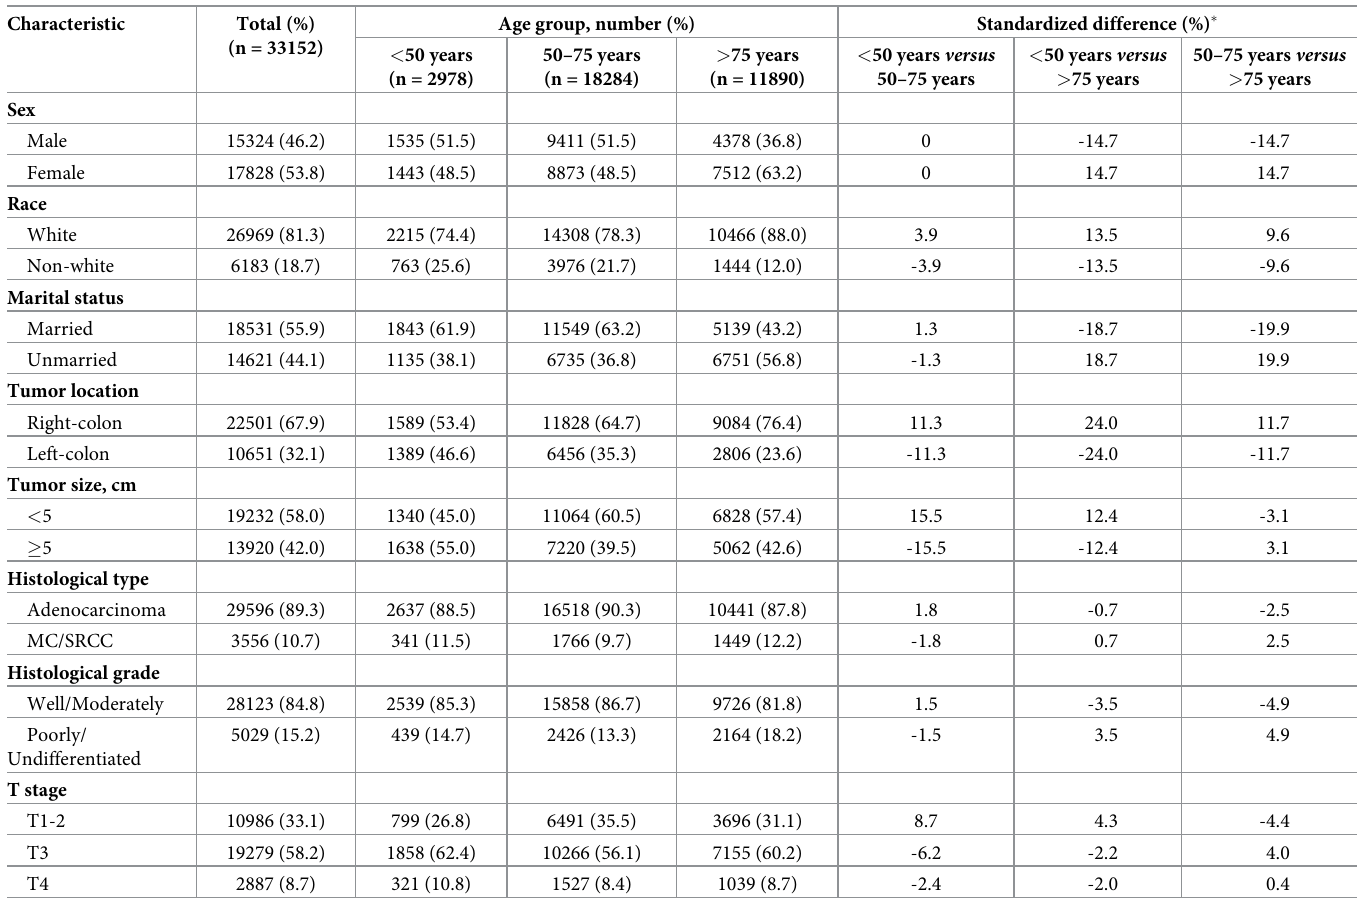
Table 1. Characteristics of colon cancer patients by age-group.